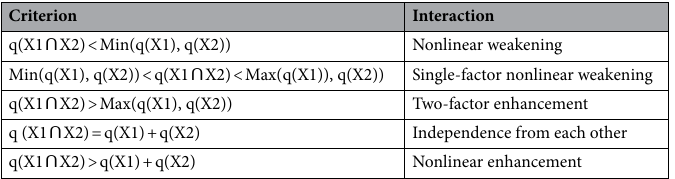
Table 3. Types of interactions between two